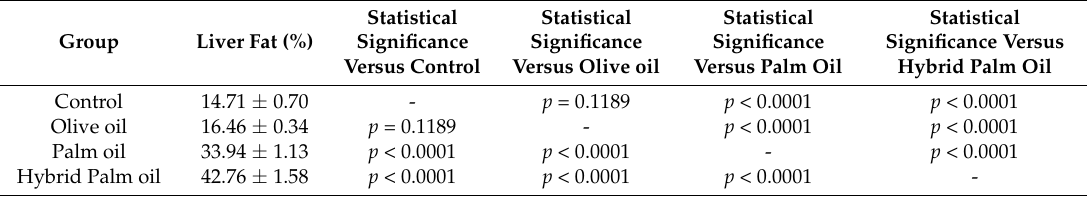
Table 1. Liver fat measurements in mice submitted to a high-fat diet protocol (%).